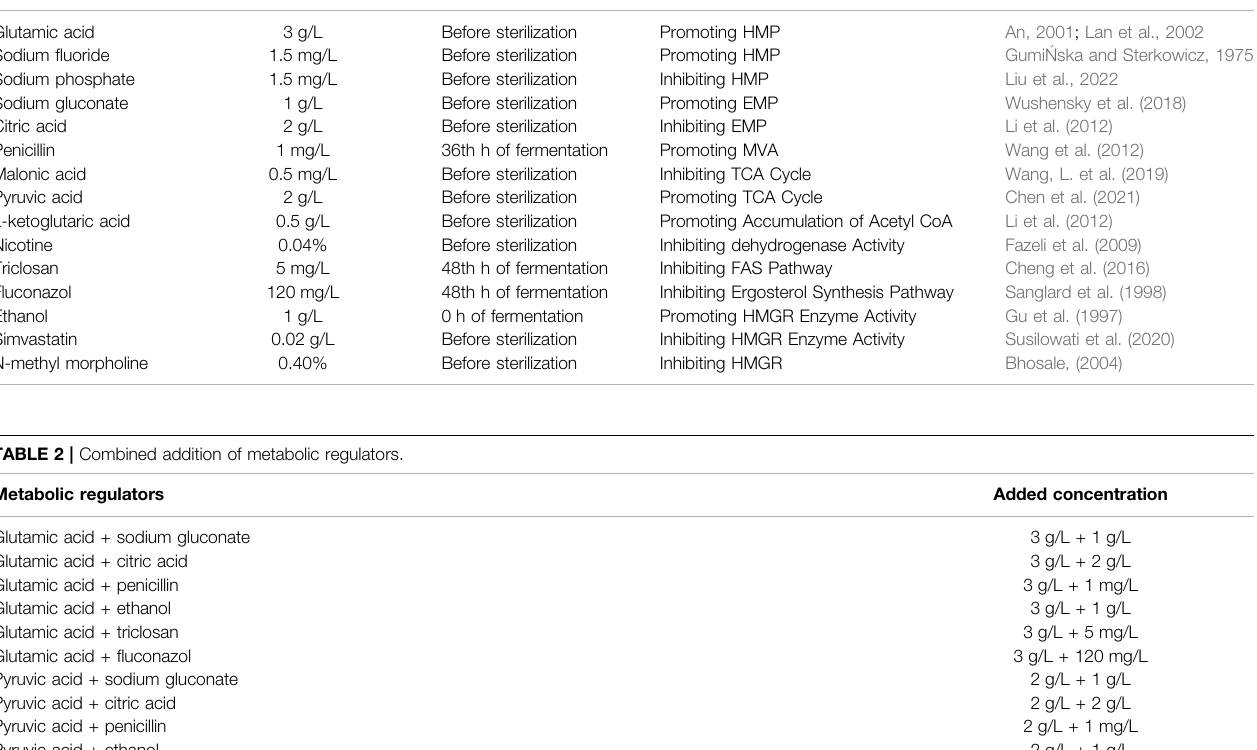
TABLE 1 | Adding method of metabolic regulators. Metabolic regulators